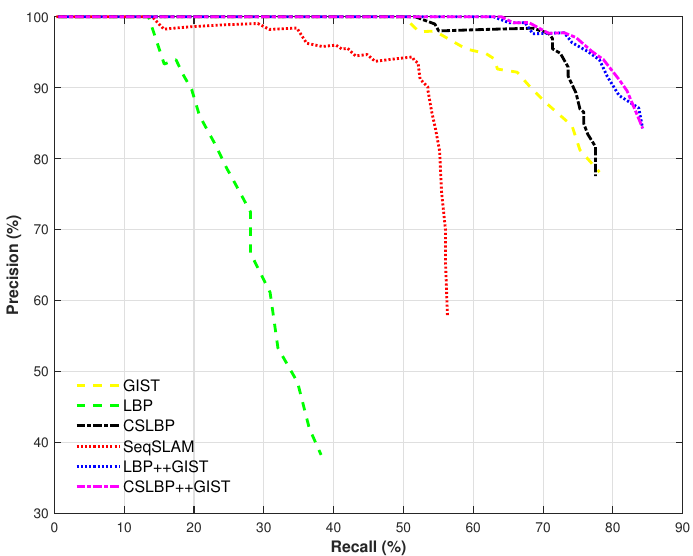
Figure 5. Performance of the proposed method according to different used features and in comparison with the SeqSLAM method (summer vs. winter, sequence length is